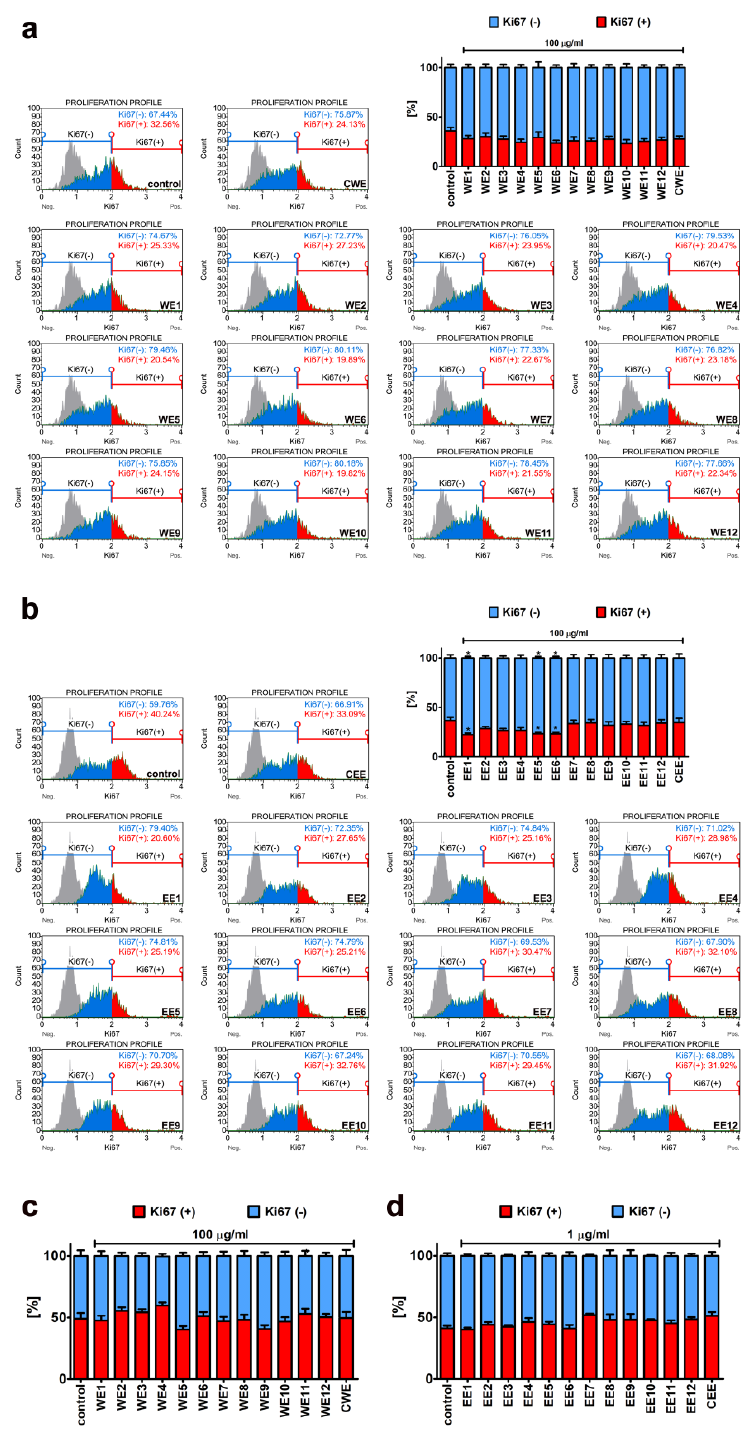
Figure 4. Extract-mediated changes in cell proliferation of BJ cells (( a ), 100 µ g / mL water extracts; ( b ), 100 µ g / mL ethanolic extracts) and HEK cells (( c ), 100 µ g / mL water extracts; ( d ), 1 µ g / mL ethanolic extracts). ( a , c ) The e ff ects of water extracts (WE, twelve modified clones from WE1 to WE12) are shown. Control clone water extract is denoted as CWE. ( b , d ) The e ff ects of ethanolic extracts (EE, twelve modified clones from EE1 to EE12) are shown. Control clone ethanolic extract is denoted as CEE. Cell proliferation was assayed using a Muse ® Cell Analyzer and a Muse ® Ki67 Proliferation Kit. Representative histograms are presented (BJ cells). A negative control without incubation with Ki67 specific antibody is denoted as a grey histogram in each analyzed sample. Bars indicate SD, n = 3. * p < 0.05 compared to the control (ANOVA and Dunnett’s a posteriori test).